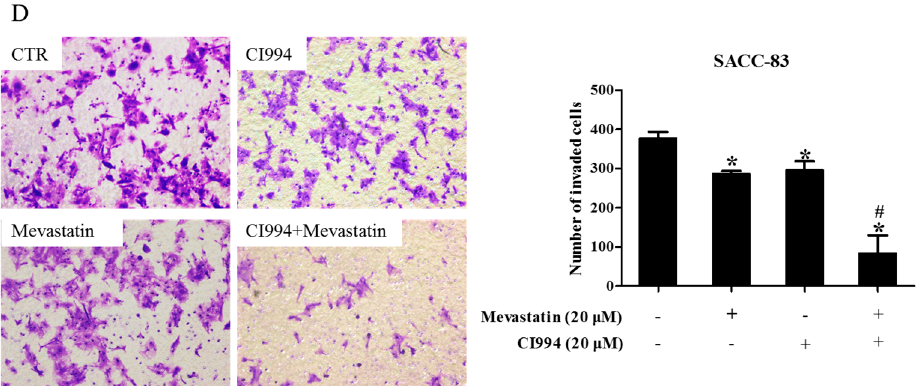
Figure 2. Inhibition of HDAC1 also enhanced statin-induced anti-cancer effects. ( A ) SACC-83 and CAL-27 cells were either exposed to various kinds of HDAC inhibitors (FK228, inhibitor for HDAC1&2; CI994, inhibitor for HDAC1; CAY10683, inhibitor for HDAC2), or together with mevastatin for 48 h. Cell viability assessed by CCK8 assay. * P < 0.05 vs. the control group; # P < 0.05 vs. mevastatin group; $ P < 0.05 vs. FK228 group; % P < 0.05 vs. CI994 group, n = 4; ( B ) SACC-83 and CAL27 cells were treated with either HDAC1 siRNA or mevastatin, or both. Cell viability was assessed by CCK8 after 48 h. * P < 0.05 vs. the control group; # P < 0.05 vs. HDAC1 siRNA or mevastatin group, n = 4; Microphotographs of cell migration ( C ) and invasion ( D ) in SACC-83 cells after 16 h treatment with CI994 and mevastatin (20×). * P < 0.05 vs. the control group; # P < 0.05 vs. CI994 or mevastatin group, n = 6.